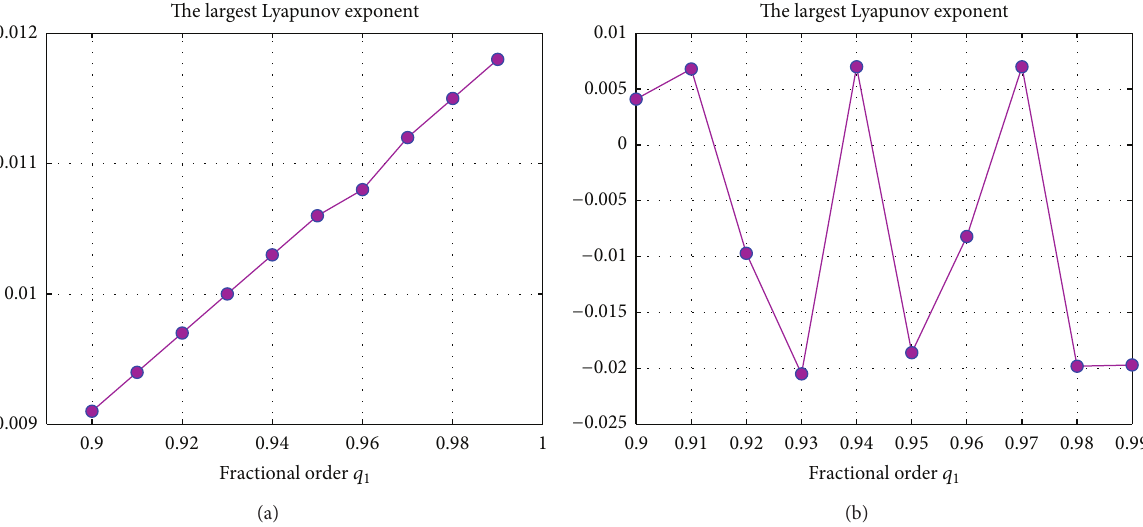
Figure 5: The Largest Lyapunov Exponent of the fractional-order power system; (a) 𝑞 2 = 𝑞 3 = 𝑞 4 = 1 , 𝑞 1 = 0.99 , and (b) 𝑞 1 = 𝑞 3 = 𝑞 4 = 1 , = 0.99 . 𝑞 2